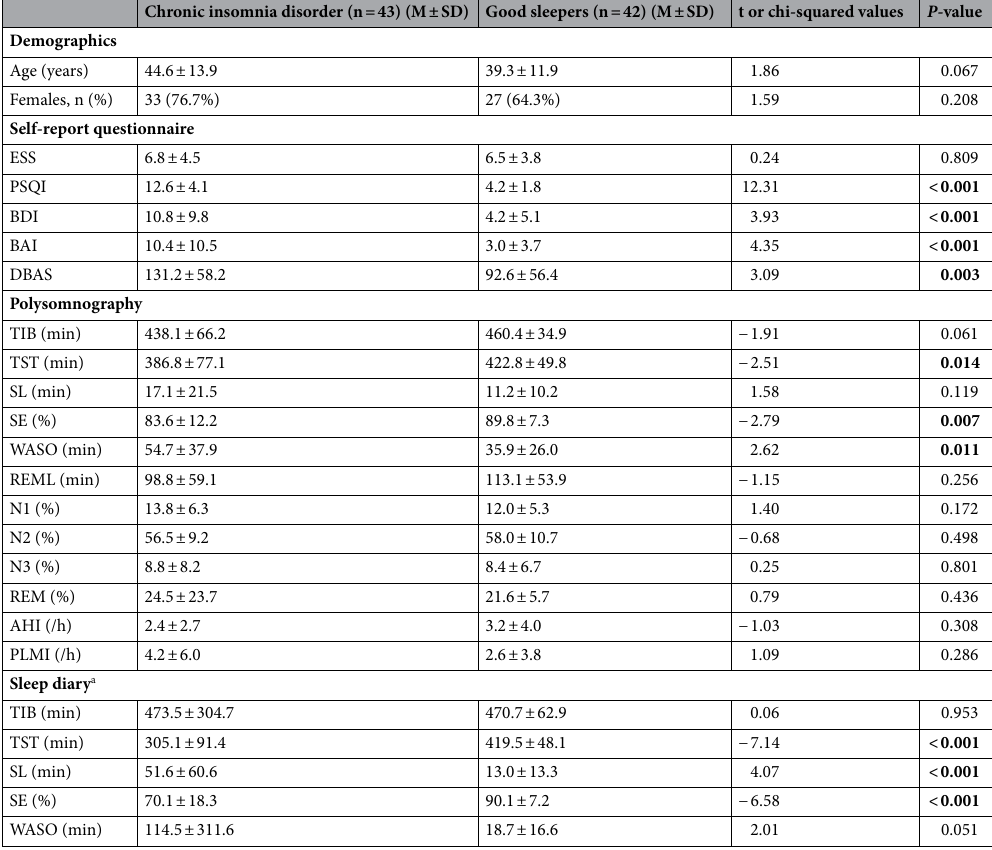
Table 1. Comparison of demographics, scores on self-report questionnaires, and polysomnography and sleep diary sleep variables between the insomnia patients and good sleepers. SD standard deviation, ESS epworth TST total sleep time, SL sleep latency, SE sleep efficiency, WASO wake after sleep onset, REML REM latency, AHI apnea–hypopnea index, PLMI periodic limb movement index. a Sleep diary data were available for 43 CID patients and 37 GS. Significant values are in bold.